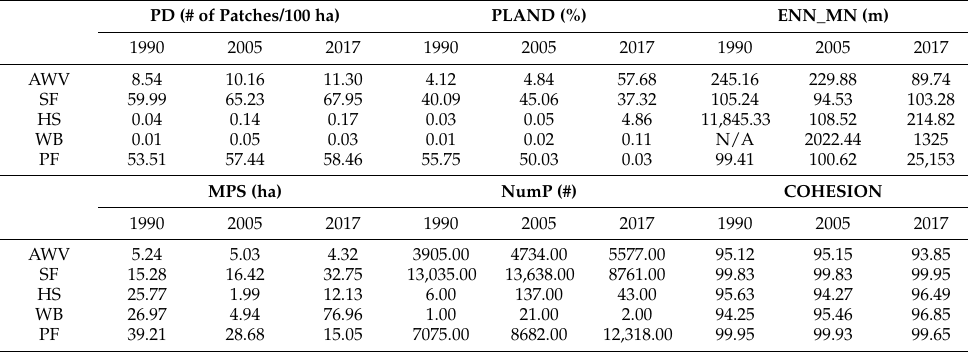
Table 6. Metrics at the class level for the land use/land cover of 1990, 2005 and 2017. PD (# of Patches/100 ha) PLAND (%) ENN_MN